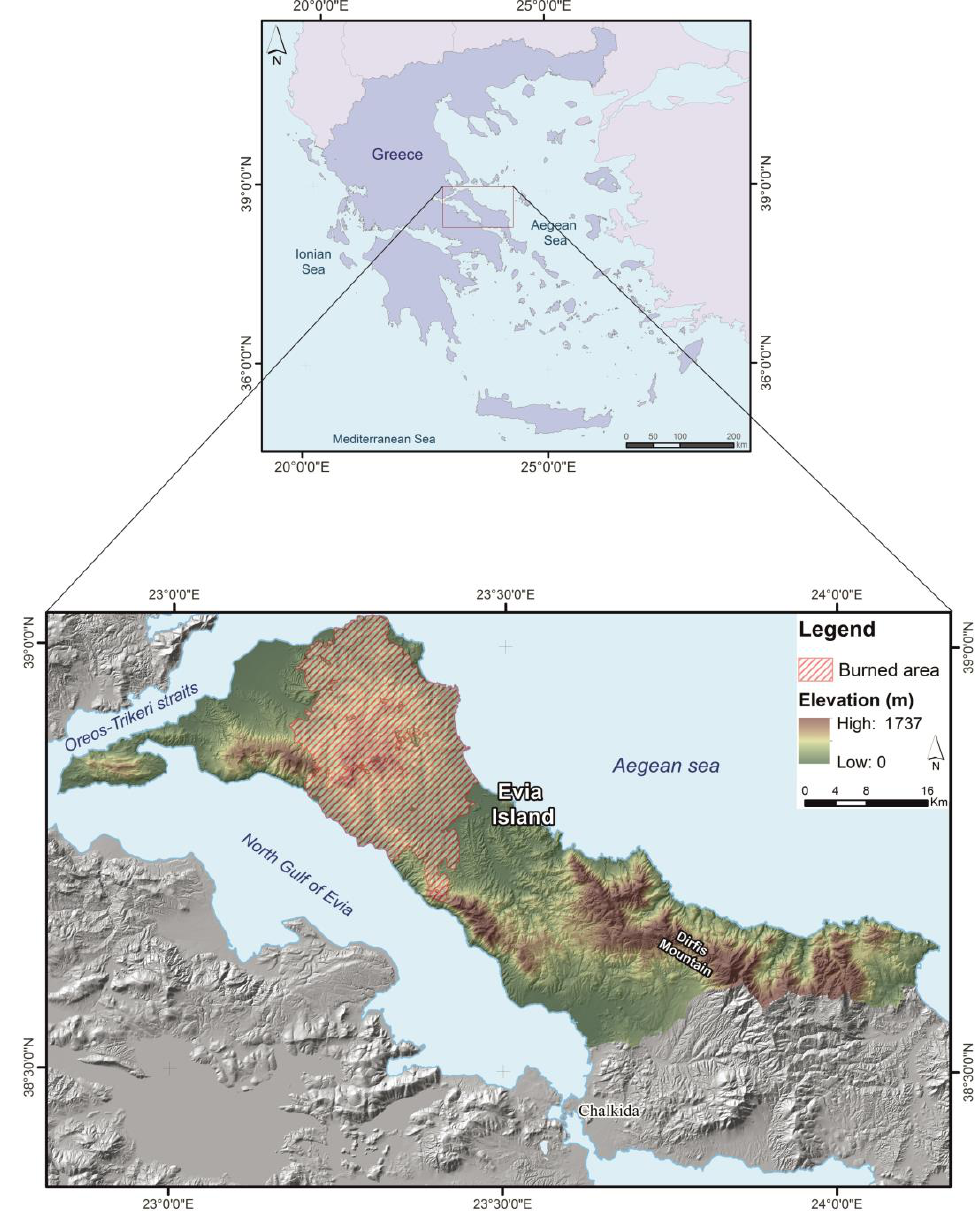
Figure 1. Digital Elevation Model (DEM) of the northern part of Evia Island, showing the location of the study area. The hatched polygon represents the burned area following the August 2021 wild- fire event.